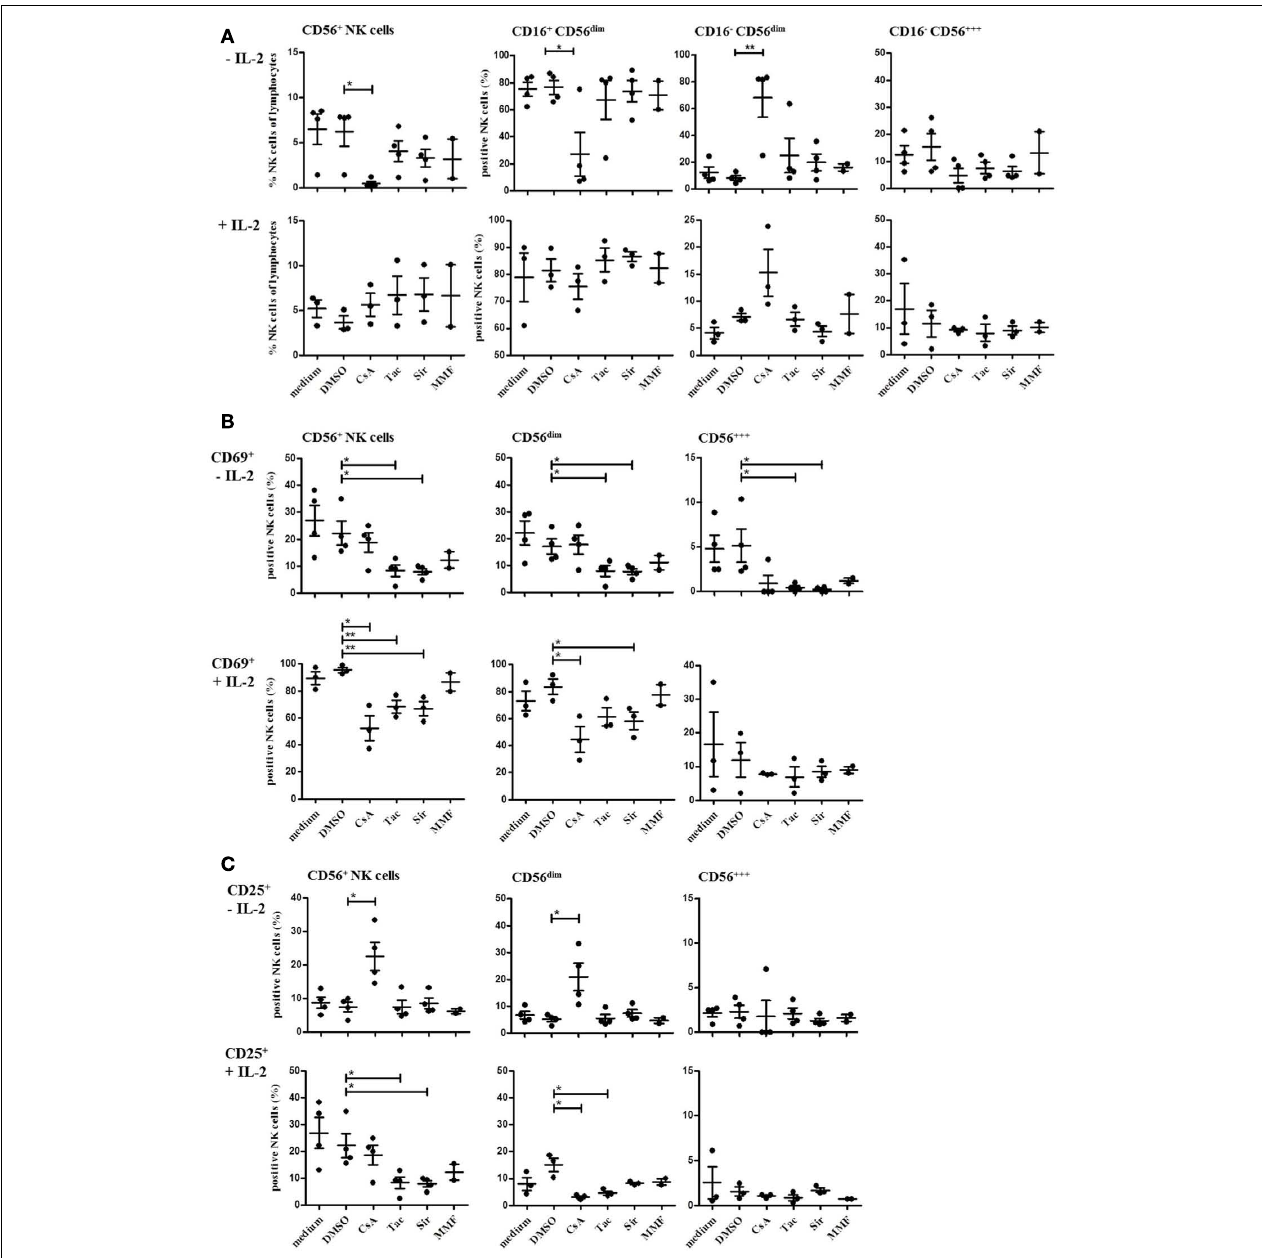
The percentage of all NK cells (CD3 − /CD56 + ) and of the major NK cell subsets defined as CD16 + /CD16 − CD56 dim and CD56 bright (A) as well as CD69 + (B) and CD25 + NK cells (C) were determined by flow cytometry. Each data point indicates one donor, and the median values with standard deviations are depicted as black